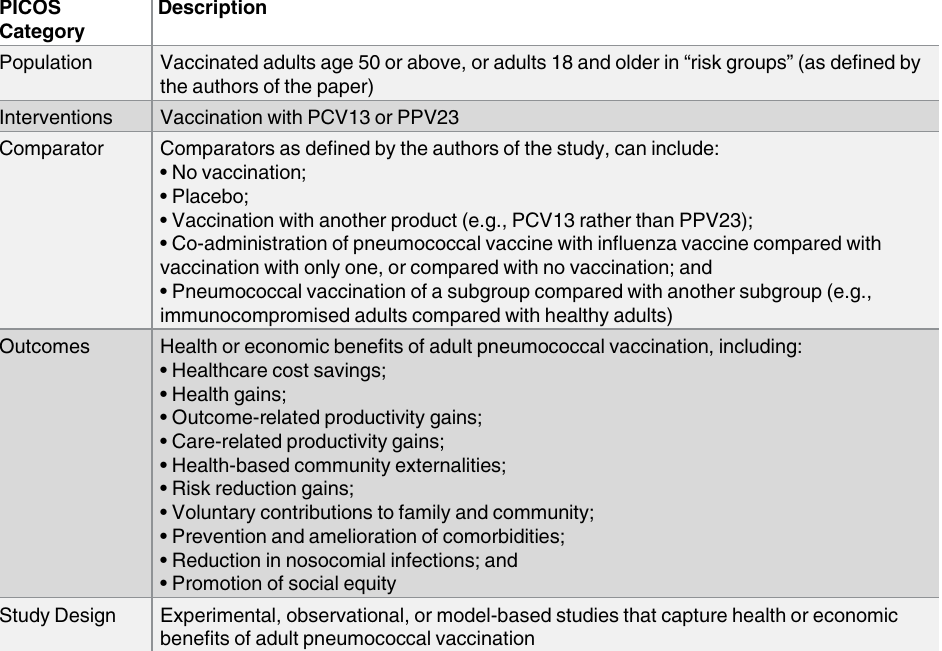
Table 1. PICOS criteria for eligibility of